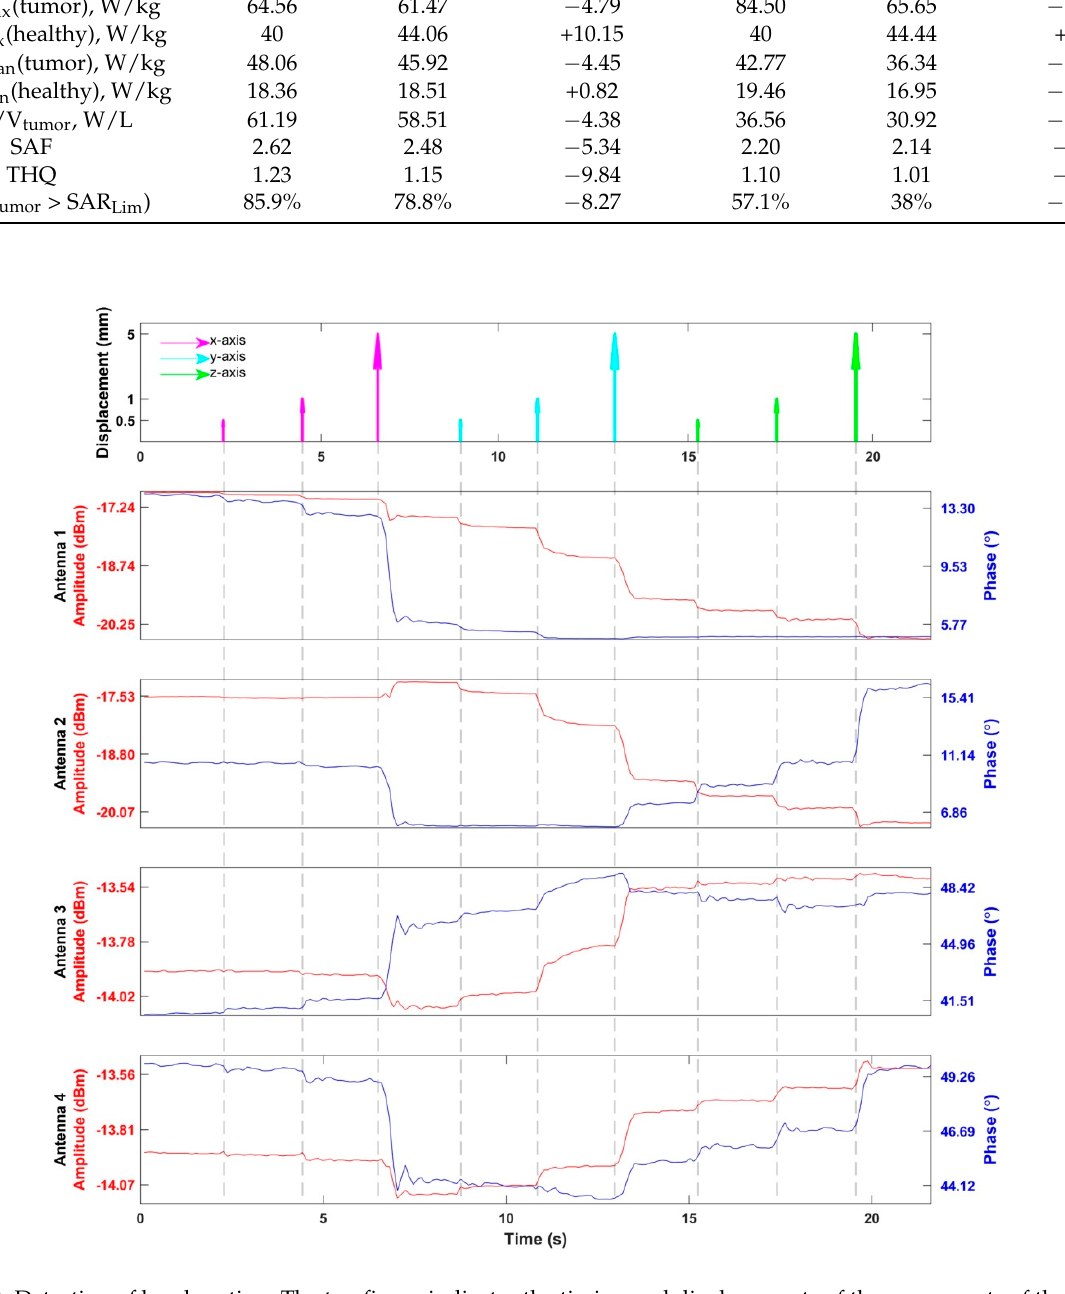
Figure 9. Detection of head motion. The top figure indicates the timing and displacements of the movements of the head model. There were three movements with the distance of 0.5, 1.0, and 5.0 mm along each direction. The following four figures show the amplitude and phase of the reflected RF signals from the SGBT antennas detected by the supervision module. The curves drawn in red represent the amplitudes of the reflected signals, while the curves in blue represent the phases of the reflected signal relative to the transmitted/reference signal.